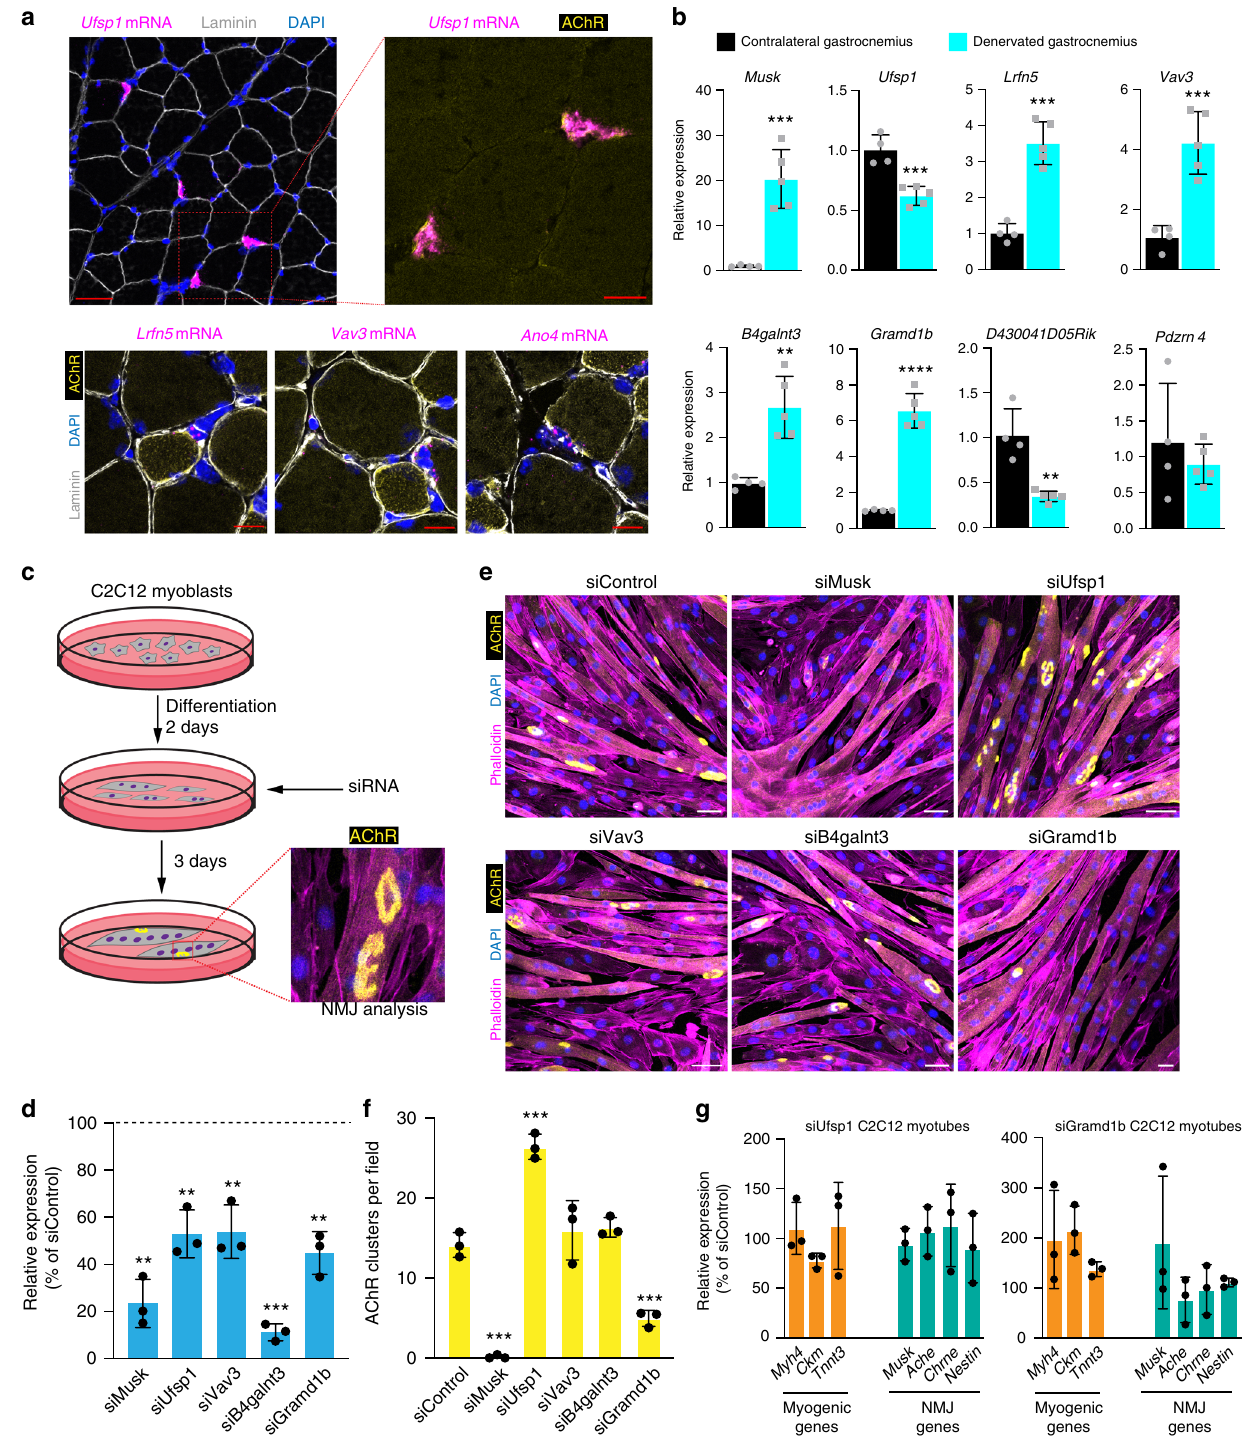
Fig. 6 Discovery and functional characterization of previously unknown NMJ marker genes. a Representative images from smRNA-FISH for Ufsp1 , Lfrn5 , Vav3 , and Ano4 on skeletal muscle sections showing co-localization with the canonical NMJ protein, acetylcholine receptor (AChR) ( n = 3). AChR was visualized through α -bungarotoxin labeling. b Quantitative real-time PCR (qPCR) analysis for the indicated genes not previously associated with the NMJ from normal ( n = 4) and denervated ( n = 5) muscle. c Schematic for a siRNA screen in C2C12 myoblasts designed to test the function of candidate NMJ genes. siRNA was transfected two days after differentiation and three days later α -bungarotoxin was used to analyze AChR clustering as a surrogate for NMJ formation. d qPCR analysis for the genes targeted with siRNA. A scrambled siRNA was used as a control. e Representative images of C2C12 myotube cultures after treatment with various siRNAs and staining with α -bungarotoxin. Cells were also stained with phalloidin and DAPI. f Quanti fi cation of AChR clusters per fi eld of view from e . g qPCR analysis for genes associated with myogenesis and NMJ formation. Scale bars: a 50 μ m (top left panel), 10 μ m (top right and bottom panels), e 50 μ m. Data in d , f , and g are from three independent experiments. All data are represented as mean±standard deviation. An unpaired two- sided t -test was used to determine statistical signi fi cance, ** P <0.01, *** P <0.001, **** P <0.0001. Source data are provided as a Source Data fi